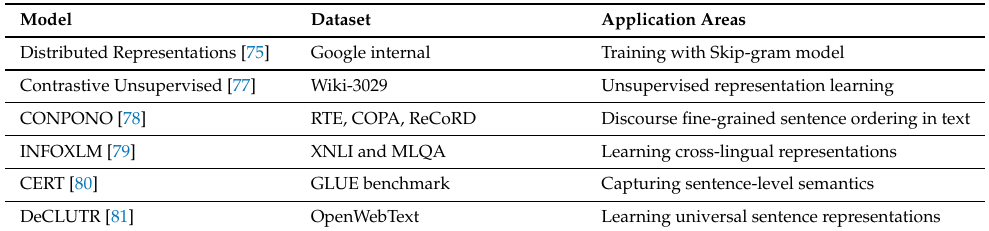
Table 5. Recent contrastive learning methods in NLP along with the datasets they were evaluated on and the respective downstream